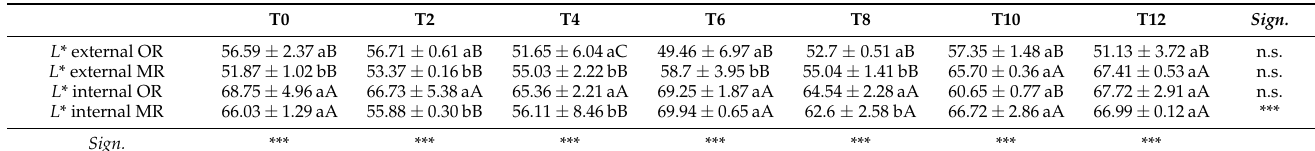
Table 1. Colours and L * values of Cantuccini biscuits made using the original recipe (OR; 50% butter/50% margarine) and modified recipe (MR; 70% EVOO/30% butter). One-way ANOVA, means ± SD (of six replicates) in the same row followed by a different letter are significantly different according to Tukey’s test; *** p < 0.001. Means in the same column are distinguished by capital letters. Means in the same line are distinguished by small letters.